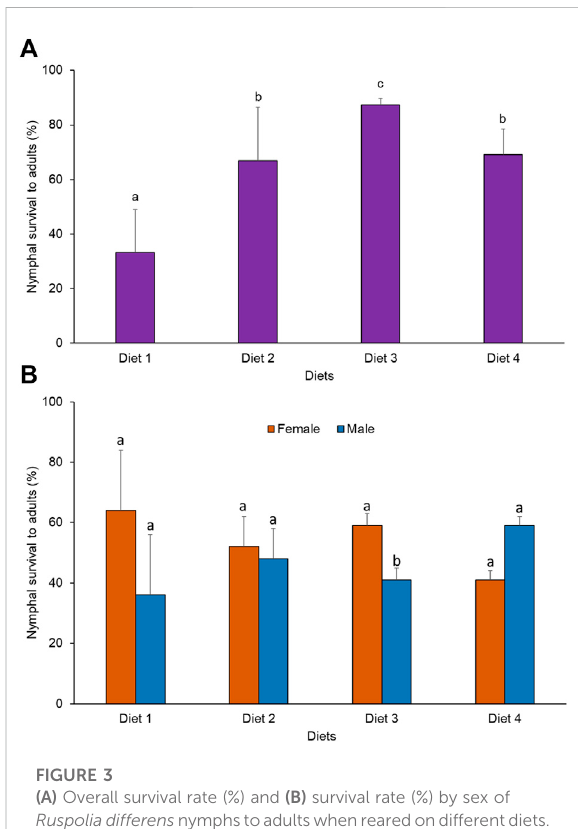
Ruspoliadifferens nymphstoadultswhenrearedondifferentdiets. Means capped with different letters differed signi fi cantly (Tukey HSD, p < 0.05) FIGURE 4